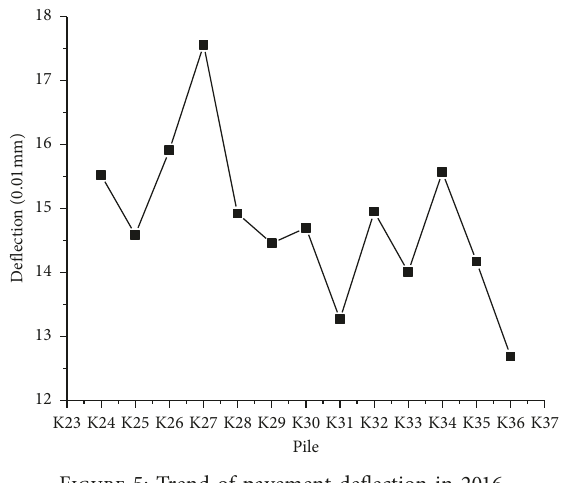
Figure 5: Trend of pavement deflection in 2016.